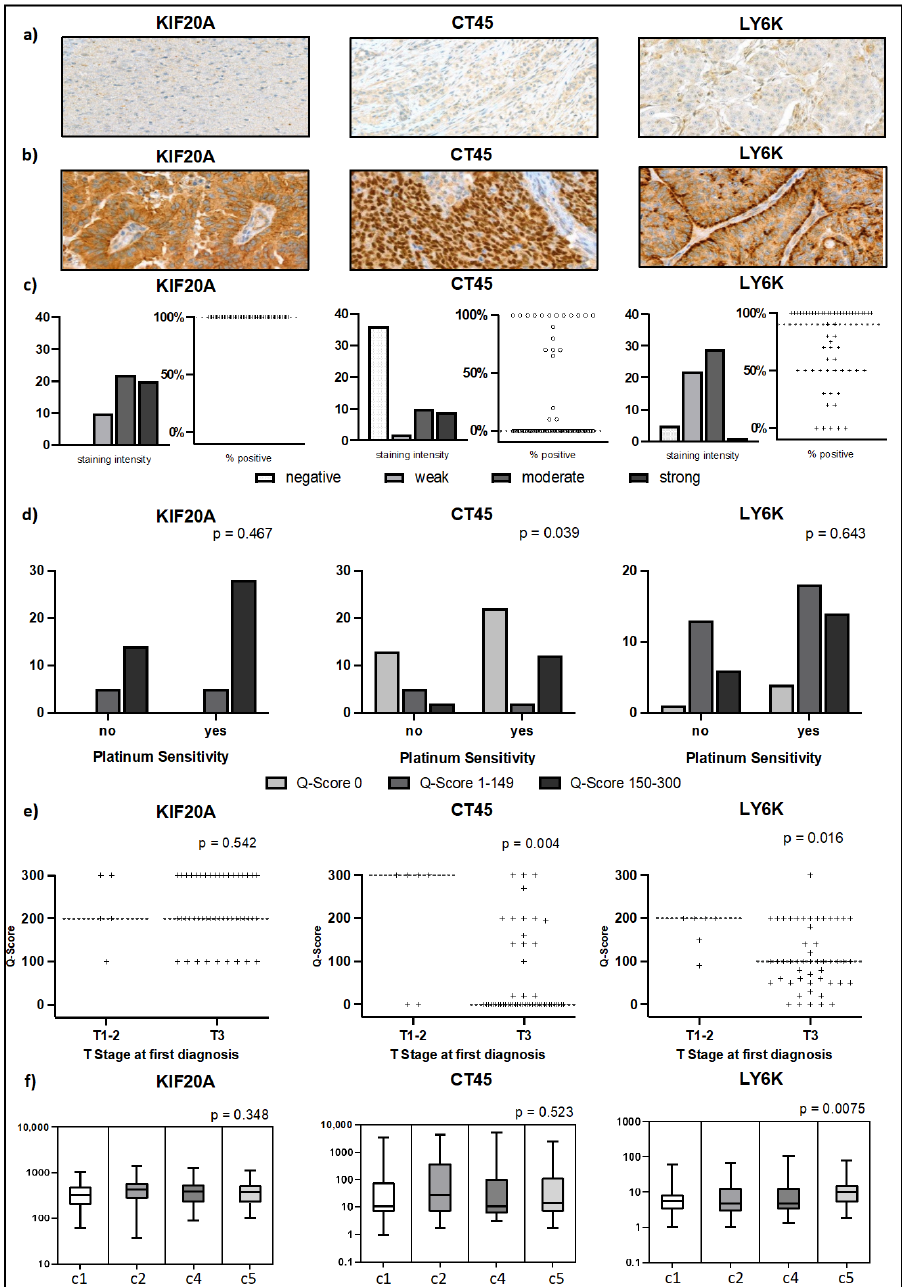
Figure 3. Results of IHC staining and clinicopathological analysis for KIF20A (left), CT45 (middle), and LY6K (right column): ( a , b ) representative stainings in tissue micro array of EOC, showing an example of weak ( a ) and strong ( b ) staining intensity; ( c ) results of IHC, showing number of samples with negative, weak, moderate or strong staining intensity (left) and percentage of tumor cells with positive staining for each sample (right); dotted lines mark median value ( d ) platinum sensitivity of KIF20A, CT45, and LY6K in relation to Q-Score of 0, 1–149 or 150–300; ( e ) Comparison of Q-Score values with T-stage of EOC at first diagnosis; dotted lines mark median value; ( f ) box plots depicting expression of KIF20A, CT45 and LY6K in different molecular subtypes c1 (high stromal response), c2 (high immune signature), c4 (low stromal response), and c5 (mesenchymal) of EOC, as defined by Tothill et al. [142]; boxes show interquartile range, median is marked by line inside the box, whiskers range from minimum to maximum value, p -values show results of Kruskal–Wallis test for differential